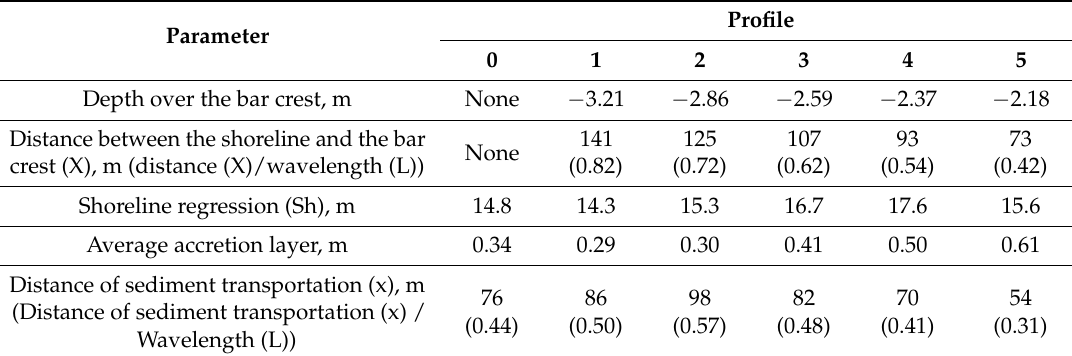
Table 2. Main changes in model profiles after 20 h of wave action.